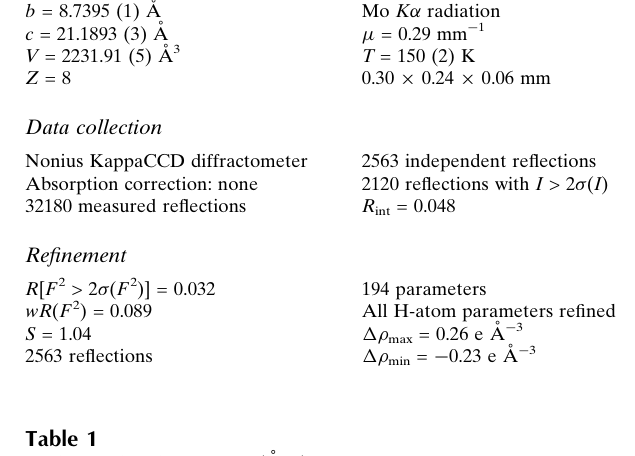
Hydrogen-bond geometry (A˚ , (cid:3)